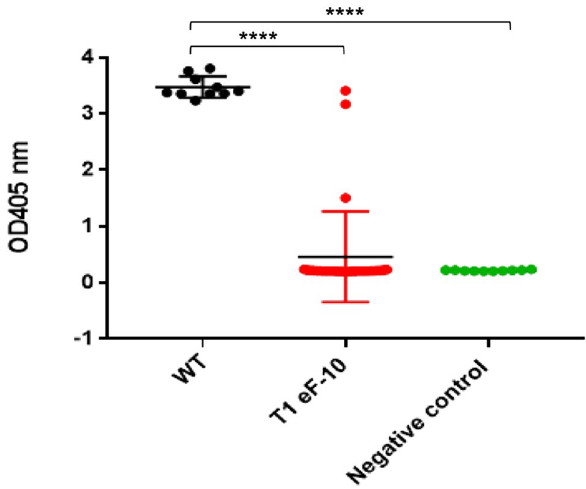
Figure 6. Analysis of PVY accumulation in T1 generation of the eF-10 line. PVY O accumulation in the systemic leaves of infected plants was assessed by DAS-ELISA at 4 weeks post-inoculation; WT wild type plant, T1 eF-10 T1 progeny of eF-10 line; negative control: non-inoculated plant. Mean and standard errors of 405 nm absorbance (A405) values were calculated for 30 (T1 eF-10) or 10 (WT and negative control) independent plants per line; ****P < 0.0001 versus corresponding positive control